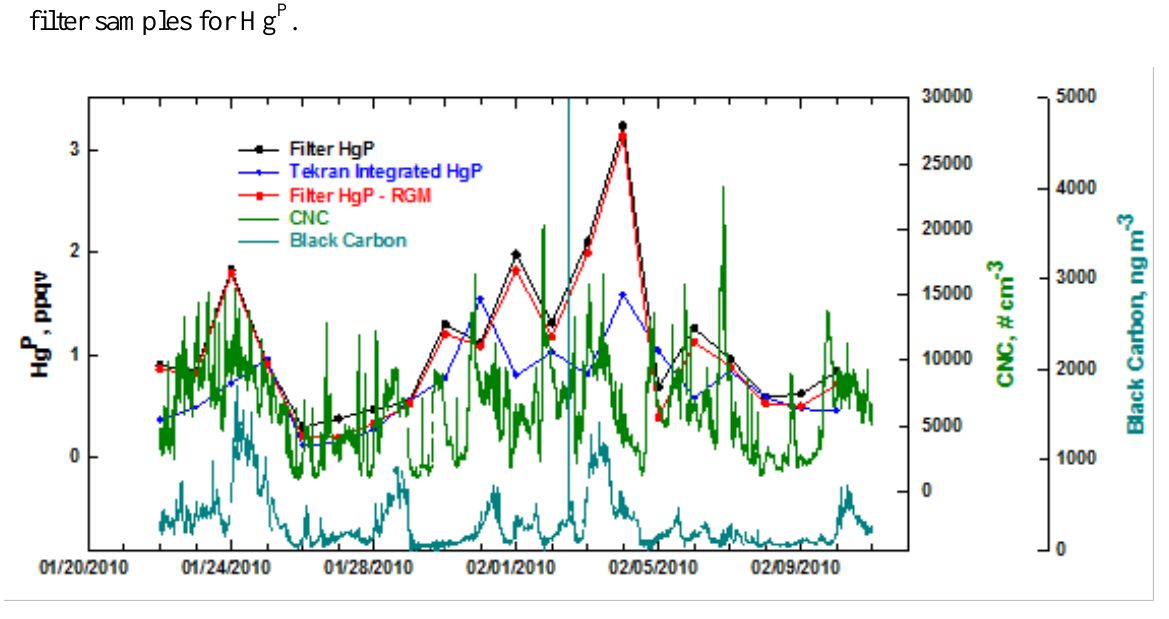
Figure 3. Time series of various aerosol measurements at Thompson Farm in spring 2010. The Tekran Hg P data was integrated to correspond to the 24 hour filter samples for Hg P